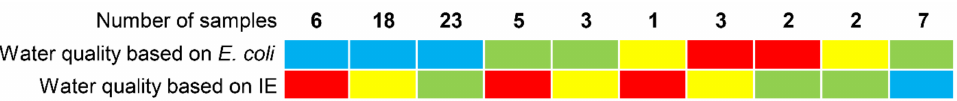
Figure 5. Water samples with different quality (blue-excellent, green-good, yellow-sufficient, red- poor) when assessed with only one indicator bacteria, E. coli and intestinal enterococci (IE) separately. The numbers indicate the number of